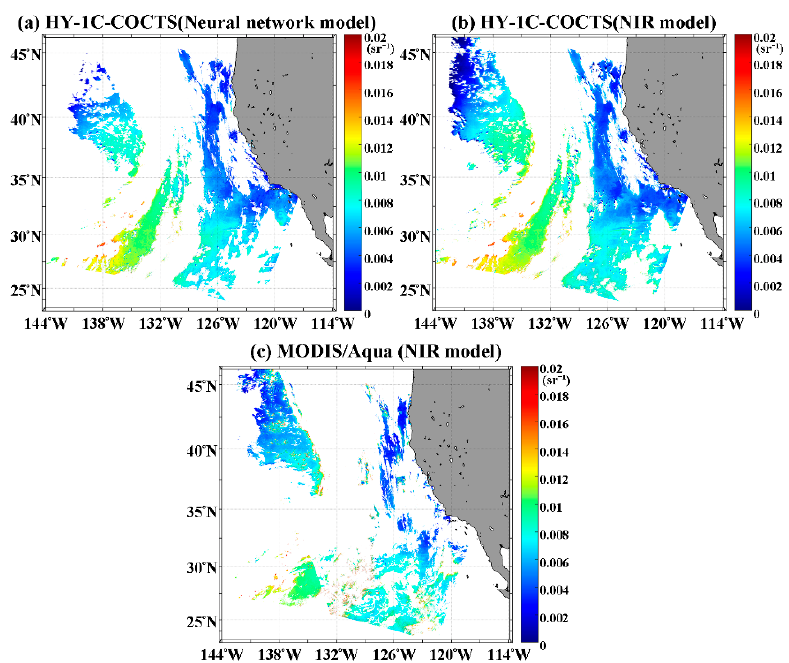
Figure 5. Satellite Rrs (443 nm) products: ( a ) HY-1C-COCTS products processed by the neural network atmospheric correction algorithm; ( b ) HY-1C-COCTS products processed by the NIR algorithm; ( c ) the product of MODIS/Aqua processed by the NIR algorithm.